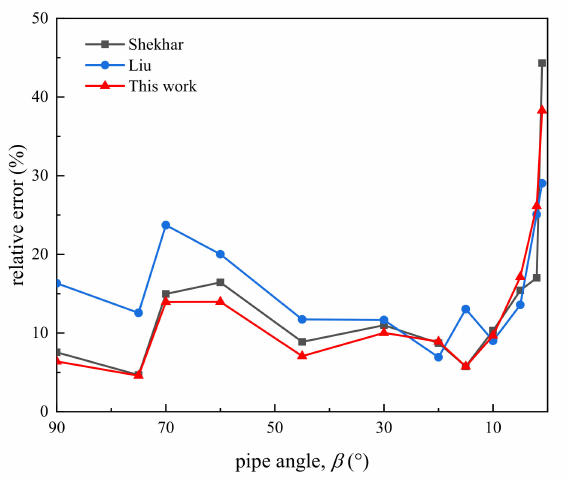
Figure 13. The relative error of different models under different pipe